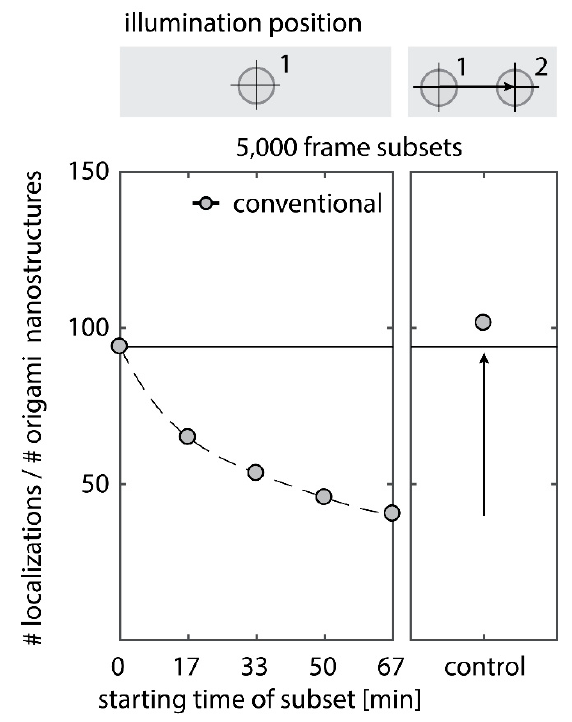
Figure A1. With increasing measurement time, the total number of localizations per DNA origami nanostructure decreases. One large time series of 25,000 frames (83 min) was drift corrected and subsequently divided into five subsets of 5000 frames (17 min each). Acquiring an additional 5000-frame- subset on the same sample in a previously not irradiated area recovers the initial number of localizations, indicating that bulk bleaching of fluorophores in solution is negligible compared to the locally observed decrease in the number of localizations.